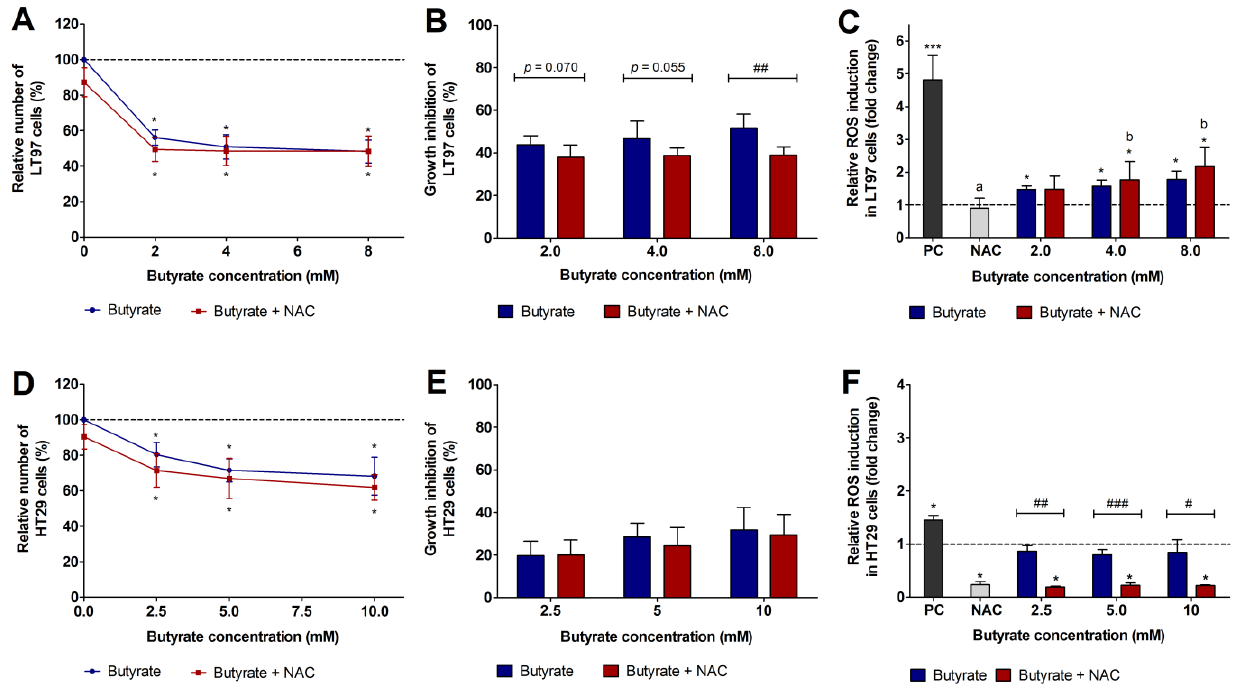
Figure 2. Relative cell number (%) ( A ), growth inhibition rate (%) ( B ) and relative ROS induction (fold change) ( C ) of LT97 cells after treatment with different concentrations (2 mM, 4 mM, 8 mM) of butyrate and co-treatment with 5 mM NAC ( N -acetyl-cysteine) and relative cell number (%) ( D ), growth inhibition rate (%) ( E ), and relative ROS induction (fold change) ( F ) of HT29 cells after treatment with different concentrations (2.5 mM, 5 mM, 10 mM) of butyrate and co-treatment with NAC for 24 h. Relative cell numbers were calculated on the basis of the medium control (dashed line) ( A , D ), which was set at 100% (mean ± SD, n = 4). Growth inhibition rates (%) ( B , E ) were calculated by subtraction of the relative cell numbers from the respective medium control (mean + SD, n = 4). Relative ROS induction (fold change) ( C , F ) was calculated on the basis of the medium control, which was set at 1 (dashed line) (mean + SD, n = 3). Significant differences are indicated as follows: compared to medium treated cells (* p < 0.05), between cells treated with different concentrations of butyrate ( − /+ NAC: a,b p < 0.05, different letters represent significantly different results), between cells treated with butyrate alone and cells treated with butyrate and NAC ( # p < 0.05, ## p <